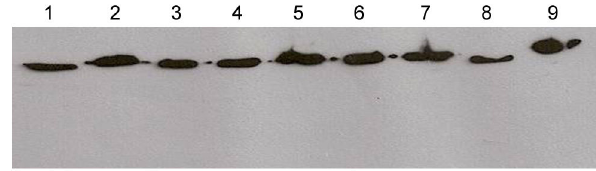
Figure 7. Immunoblot analysis with EF-Tu antiserum to different Leptospira species.